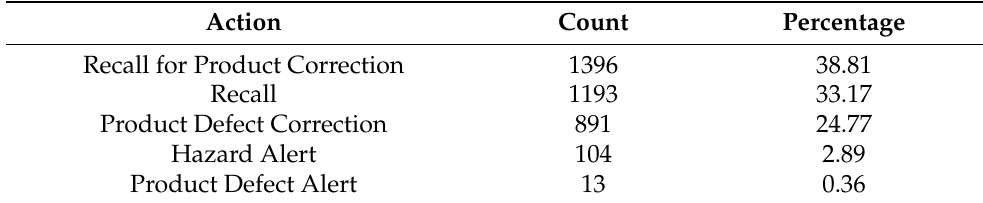
Table 1. Recall actions obtained from the System for Australian Recall Action (SARA) database for the period from July 2012 to June 2020.